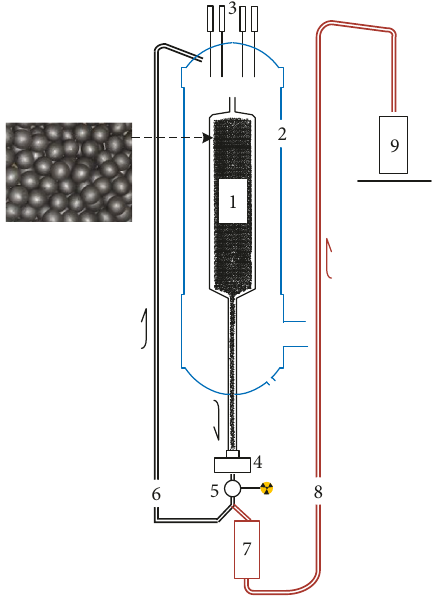
Figure 1: Online refueling of the pebble-bed HTR. 1, pebble-bed reactor core; 2, reactor pressure vessel; 3, control rod driver mechanisms; 4, scrap separator; 5, burnup measurement and switching system; 6, pipeline for fuel reloading; 7, buffering tank for spent fuels; 8, pipeline for spent fuel conveying; 9, spent fuel canister; inset, a photo of 60mm dummy pebble bed at our test